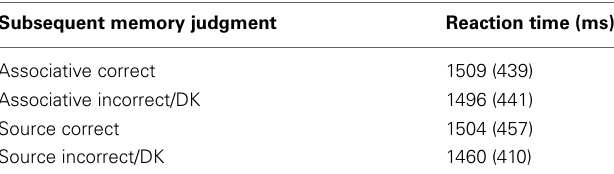
Table 1 | Mean reaction times (ms) for correct size/hand judgments at study segregated by subsequent memory (SD in